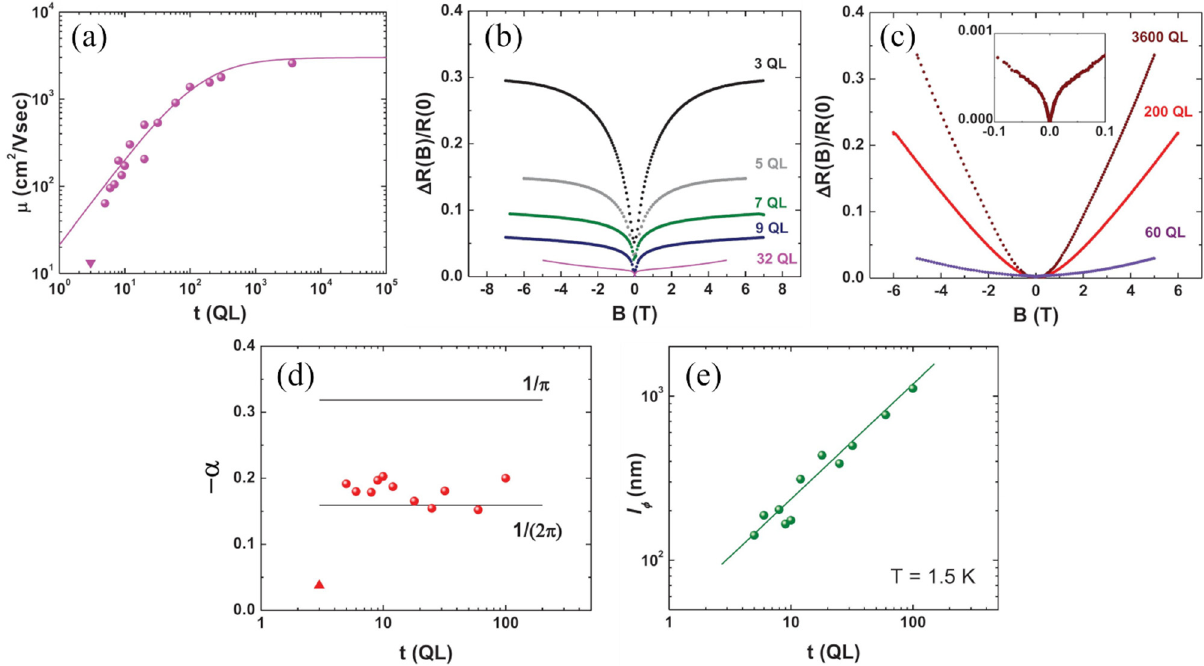
Figure 9. ( a ) Mobility against thickness following the conventional dependence of bulk transport in films, which is indicated by the solid line. ( b ) Magnetoresistance for lower thicknesses. ( c ) Magnetoresistance for high thicknesses showing the B 2 dependence characteristic of bulk dominance. Inset displays the low field region. ( d ) Parameter α against thicknesses. ( e ) l ϕ against thickness. Reprinted with permission from Reference [31]. Copyright 2011 American Physical